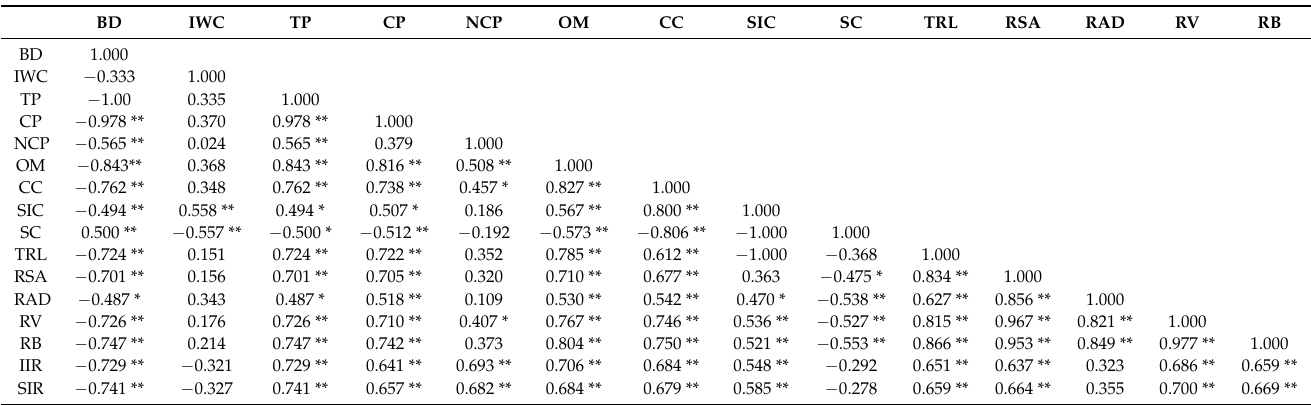
Table 4. Correlation analysis between infiltration rate and environmental